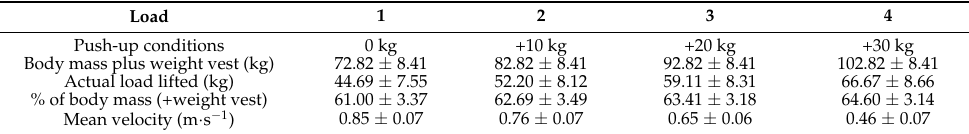
Table 2. Mean load and velocity in the four push-up conditions.